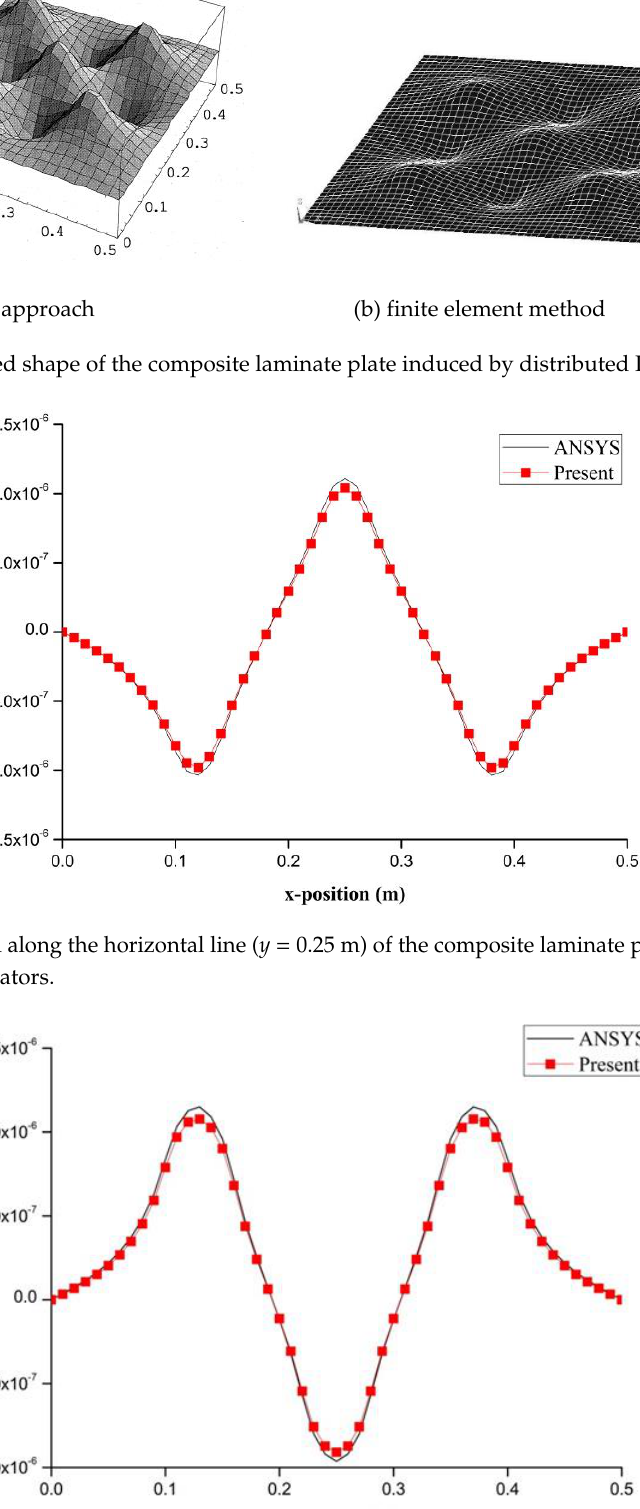
Figure 18. Deflection along the vertical line ( x = 0.13 m) of the composite laminate plate induced by distributed PZT actuators.